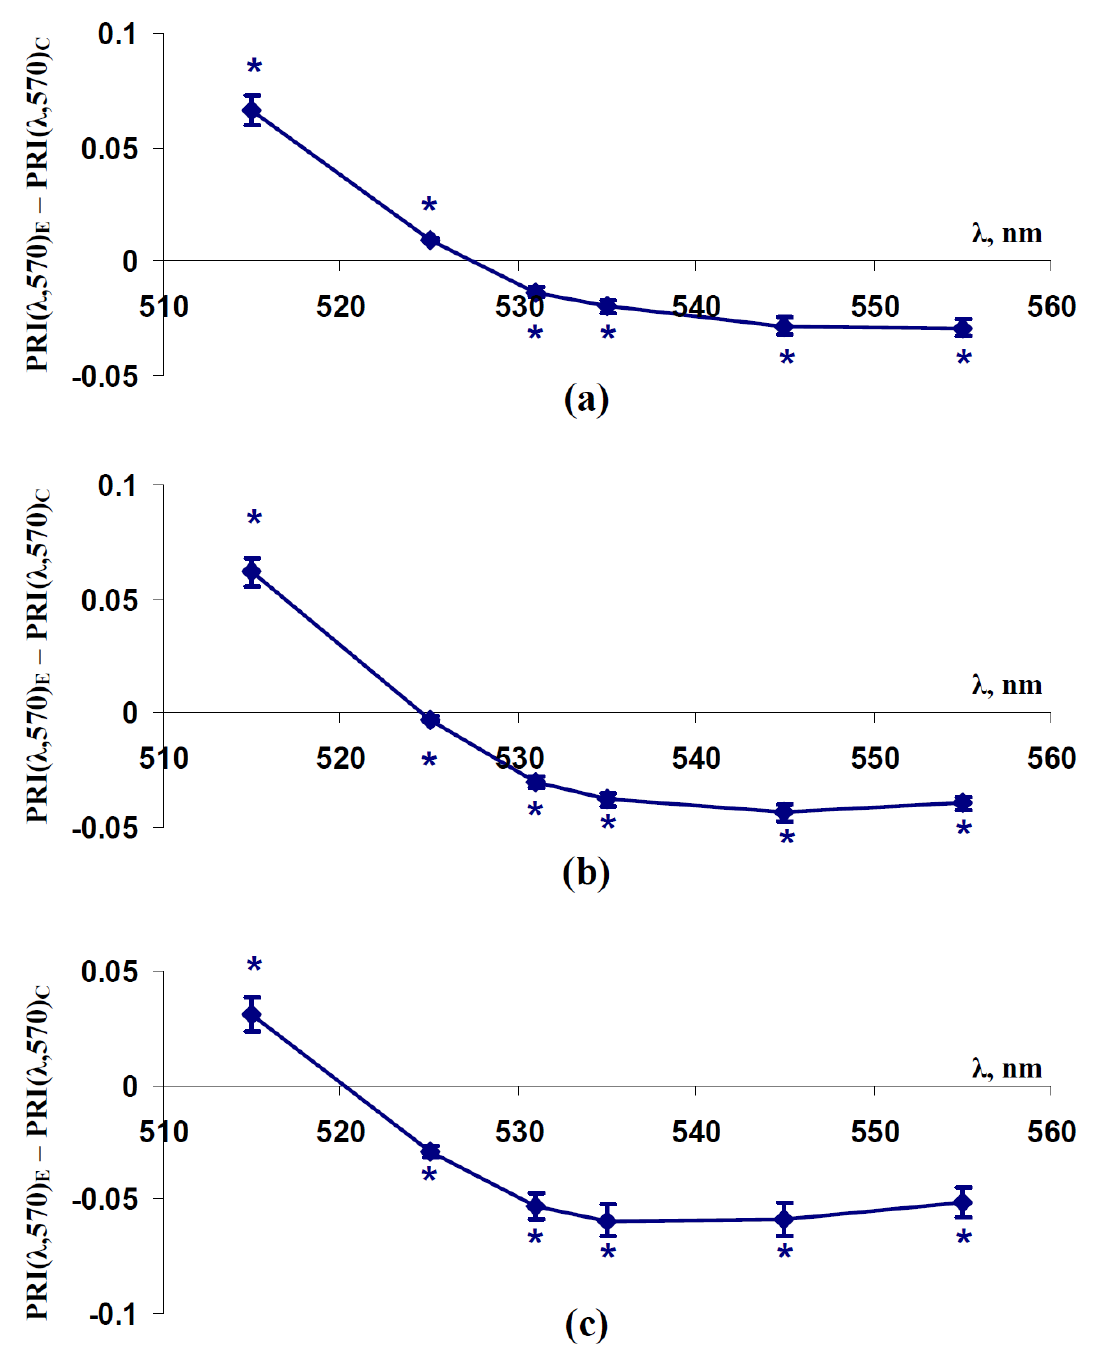
Figure 6. Dependences of difference between modified photochemical reflectance indices in canopy of plants under soil drought conditions (PRI( λ ,570) E ) and the canopy of control plants (PRI( λ ,570) C ) on wavelengths of the measuring reflected light ( λ ) in pea ( a ), wheat cultivated under conditions of a vegetation room ( b ), and wheat cultivated under open-ground conditions ( c ) ( n = 45). PRI( λ ,570) E and PRI( λ ,570) C were measured after 13 (for pea plants cultivated under conditions of a vegetation room), 17 (for wheat plants cultivated under conditions of a vegetation room), and 11 days (for wheat plants cultivated under open-ground conditions) of this drought. *, difference was significant ( p < 0.05).